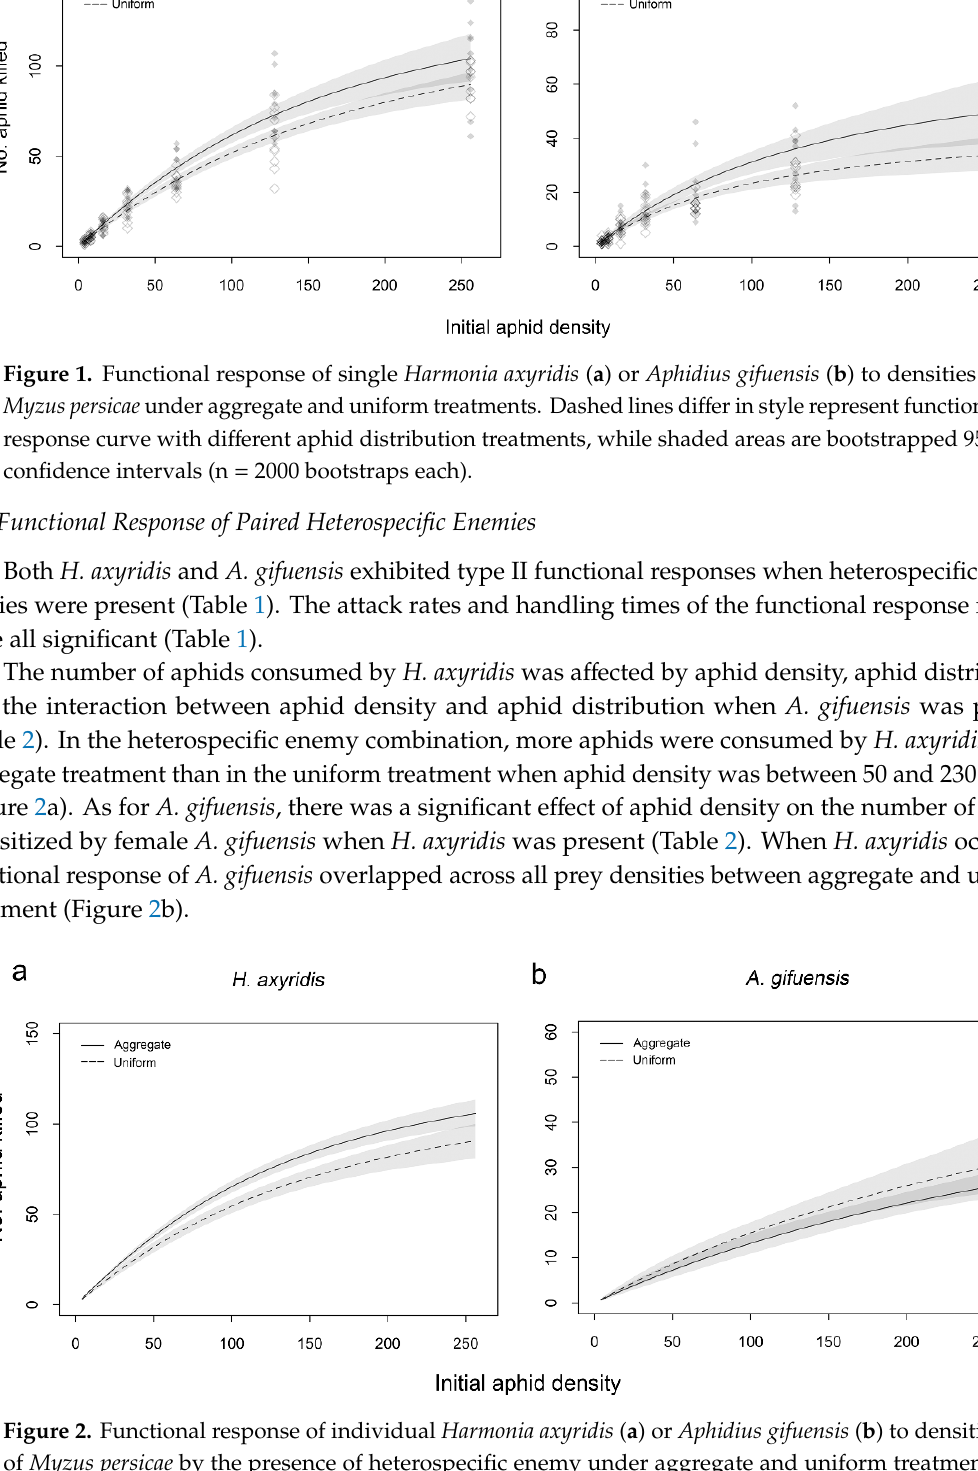
of Myzus persicae by the presence of heterospecific enemy under aggregate and uniform treatments. Shaded areas represent 95% confidence intervals (n = 2000 bootstraps